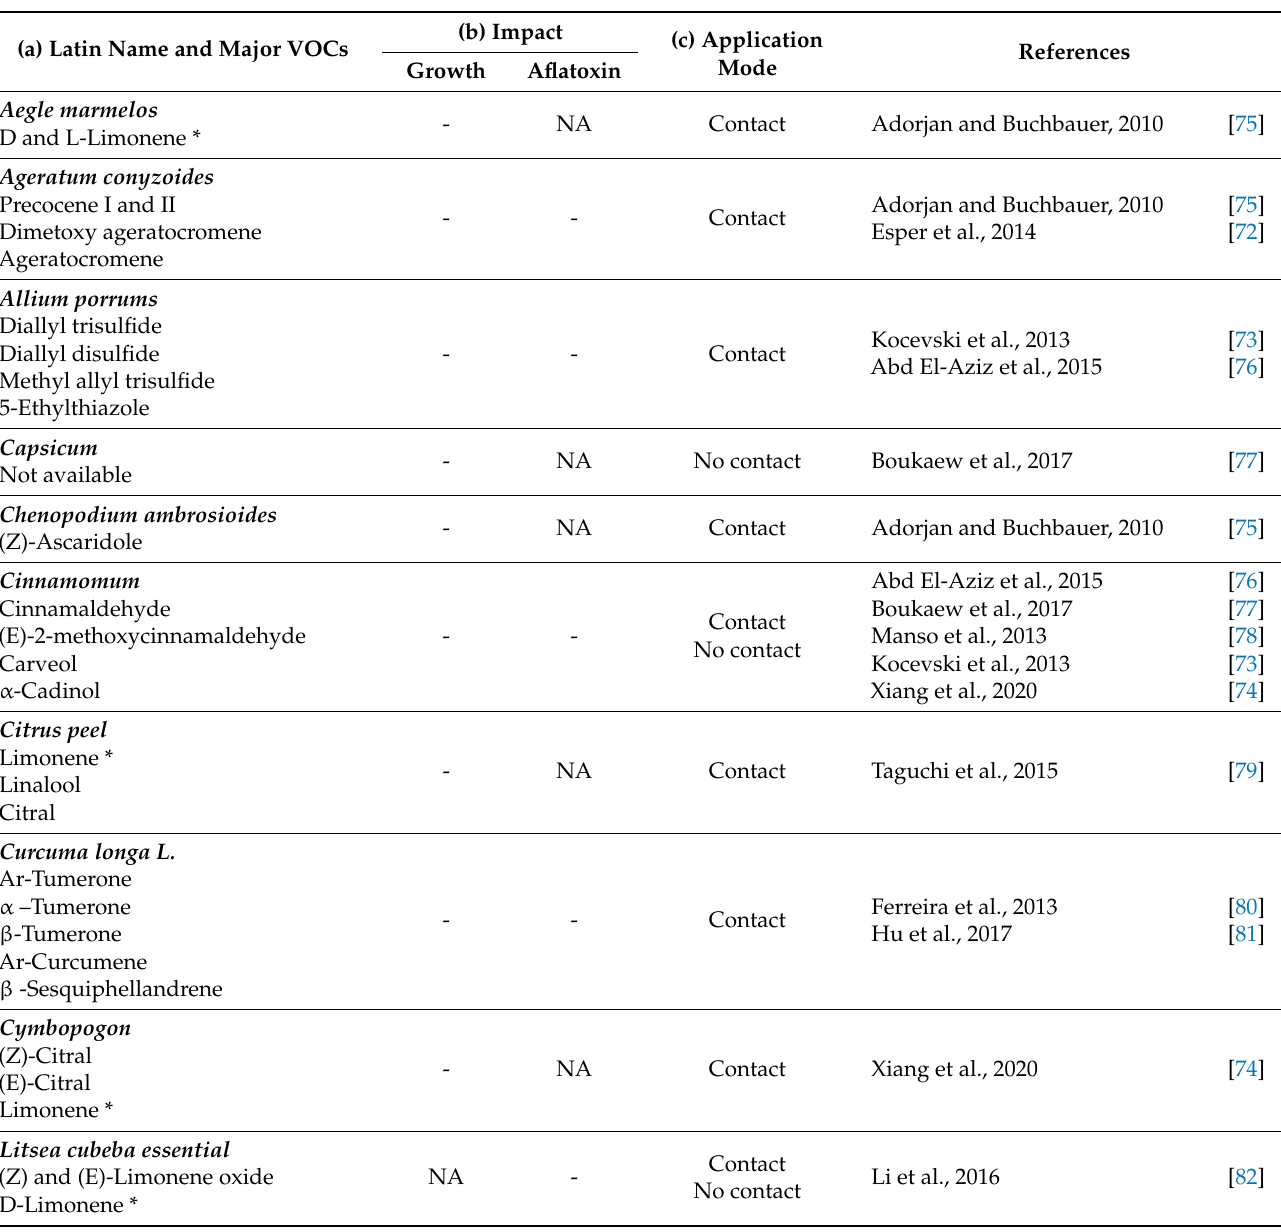
Table 4. Essential oils and their major VOCs impacting the growth of A. flavus and/or its production of